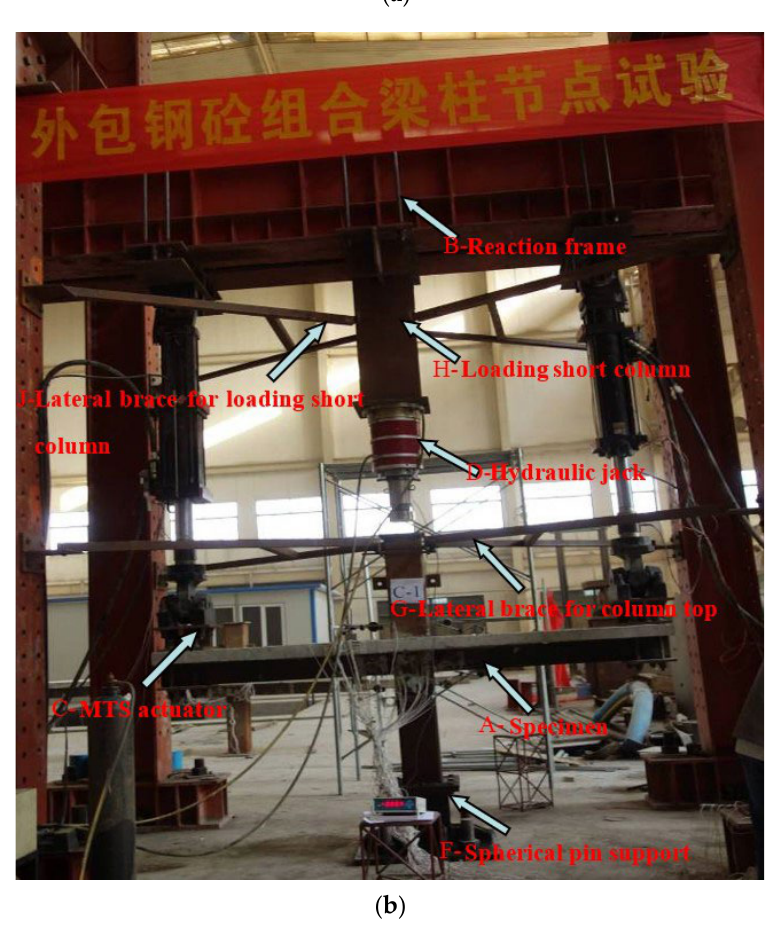
Figure 6. Test setup: ( a ) the schematic of the test setup; ( b ) test loading site. The displacement-control method was used in the loading procedure. The axial load was first imposed on the top of the column until it reached the value of the axial load ratio—as shown in Table 1—and then remained constant throughout the whole test. The vertical cyclic loads were then applied at the ends of the beams until failure. The loading cycle was repeated only once at each control point of 0.25Δ y , 0.5Δ y , and 0.75Δ y , and then repeated three times at each control point of Δ y , 2Δ y , 3Δ y , 4Δ y , etc., where Δ y represents the displacement of the beam end corresponding to the yield load estimated from the finite element analysis. The test was terminated in any of the following cases: (1) The load ca- pacity dropped to less than 85% of the peak load. (2) The concrete of the slab adjacent to the column was crushed. (3) The bottom plate of the U-shaped steel beam in the heat affect zone fractured completely. 3.3. Experimental Results All of the specimens exhibited the same behavior in terms of failure mode. When the maximum load was reached, the fracture occurred in the bottom plate and the webs of the U-shaped steel adjacent to the weld connecting between the steel tube and the bottom plate of the beam, and the was concrete crushed in the compression slab near the tube (as shown in following Figures). For all of the specimens, the deformation of the column in the connection zone was small, and no slip between the T-shaped concrete and the U- shaped steel was found up to the point of failure in all the specimens. The P– Δ hysteretic curves of three specimens are giv en in Figure 7, where P is the load imposed onto the end of the beam and Δ is the corresponding displacement. The